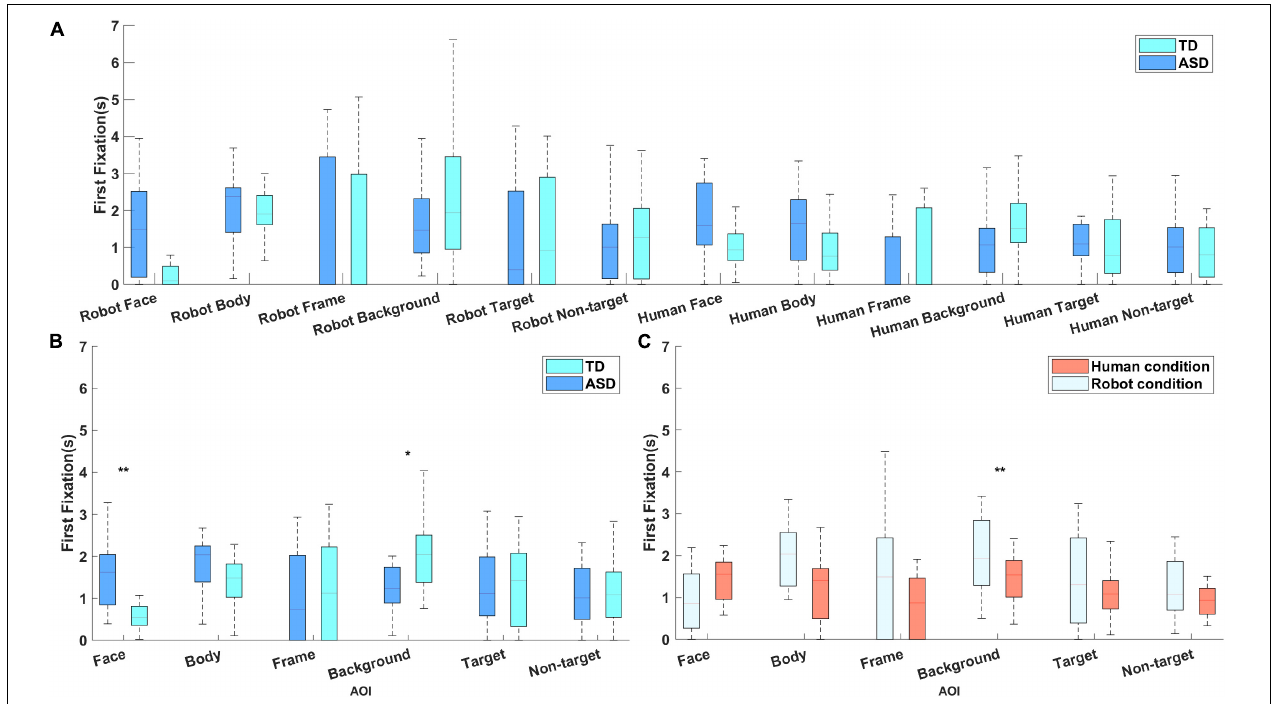
FIGURE 3 | (A) The latency (s) of participants’ first fixation on different areas of interest. (B) Results of post hoc analysis of the interaction between group and area of interest, indicating that the typically developing group looked at the face earlier than did the group with ASD, while the group with ASD looked at the background earlier than did the typically developing group. (C) The interaction between stimulus type and area of interest, demonstrating that all participants looked at the human body earlier than they looked at the robot body. ∗∗ Means that the significant level is p < 0.01 and ∗ means p <